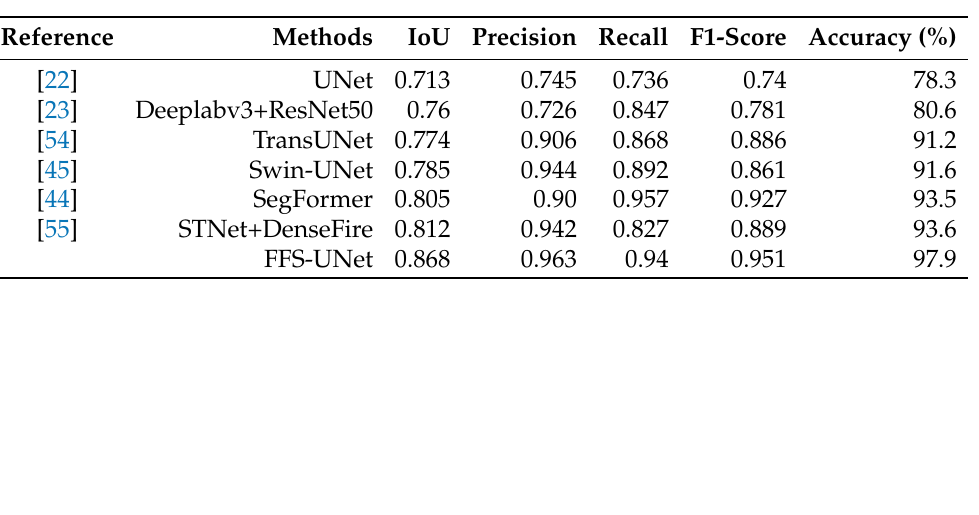
Table 6. Fire detection results, as compared to different methods, on UAV fire